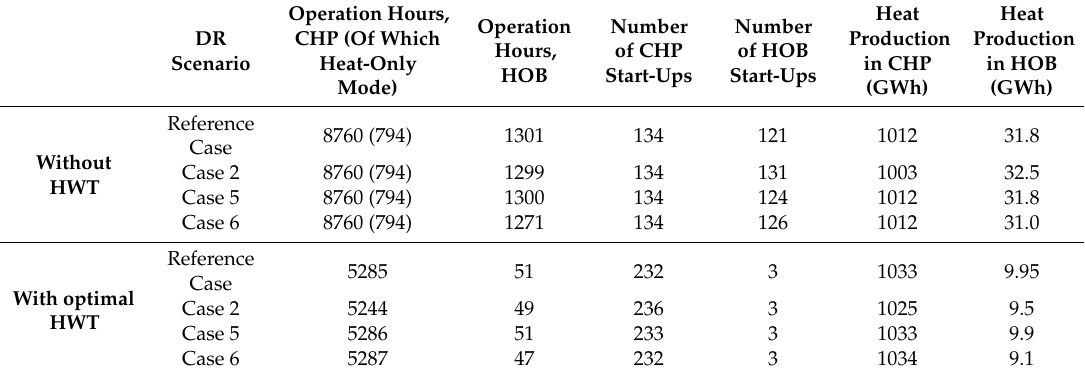
Table 5. Key operation results of the DH system in different DR cases with and without HWT in the system.